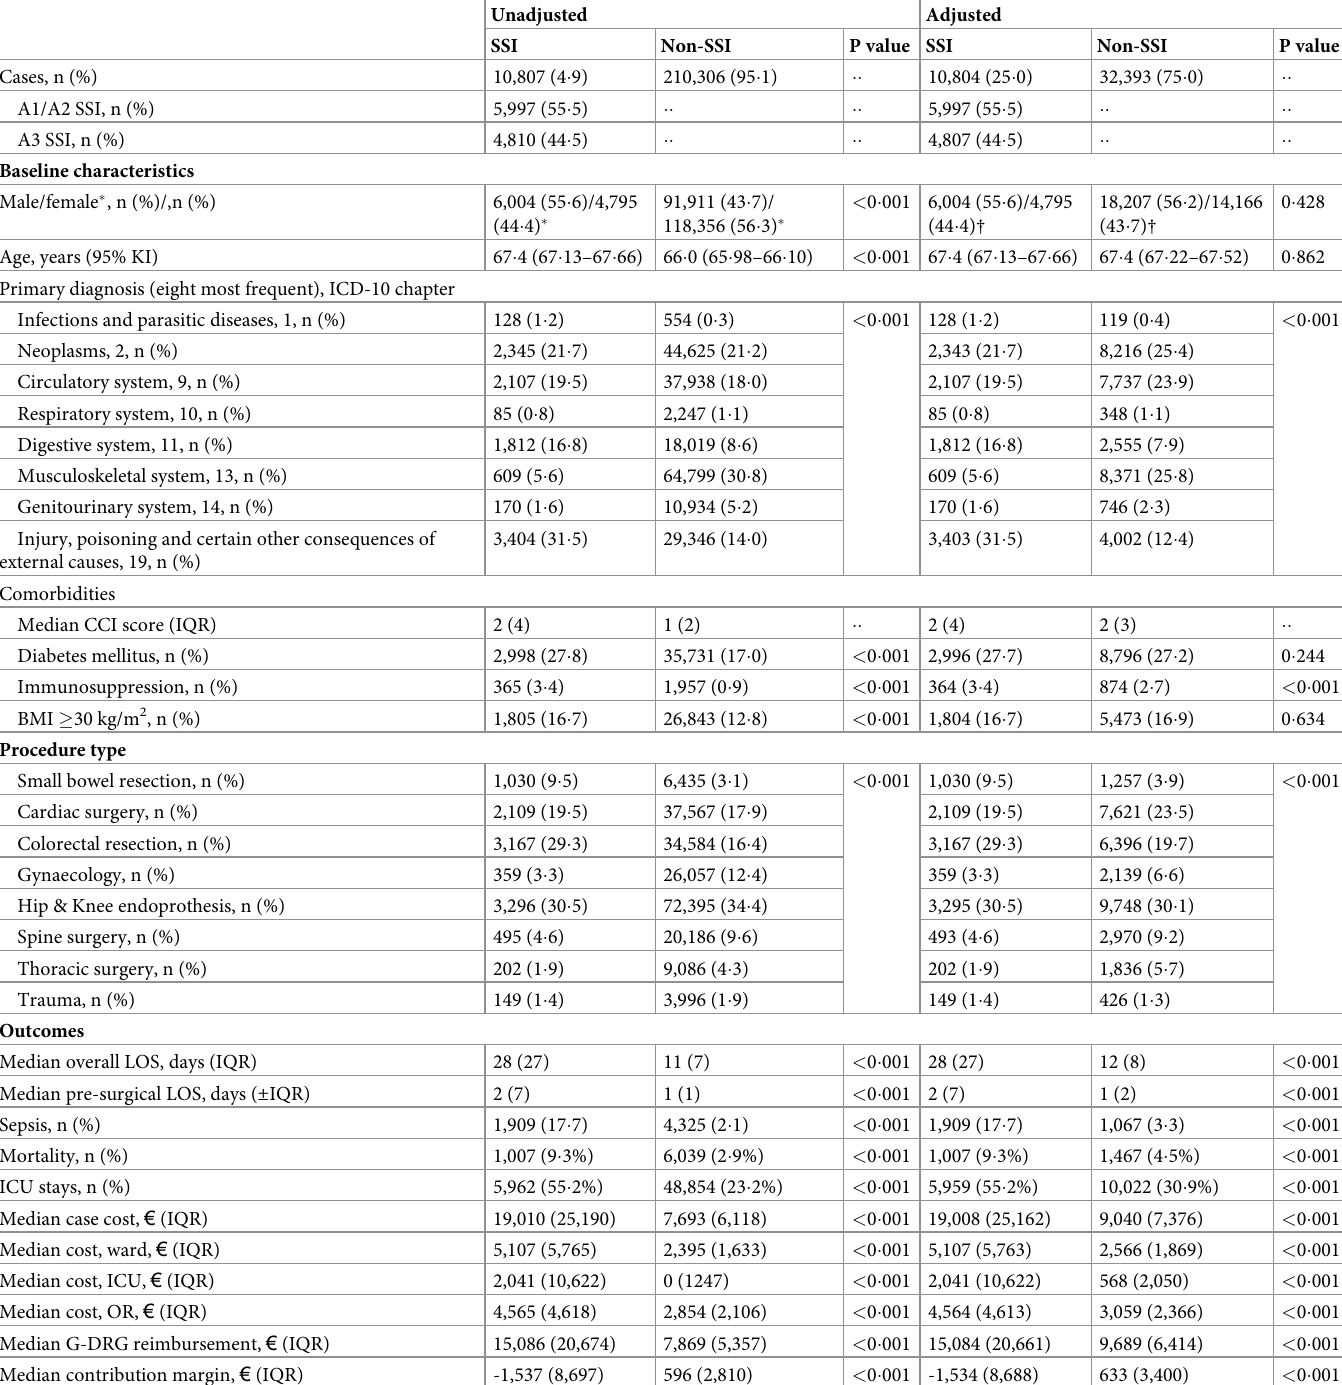
Table 3. Comparison of baseline characteristics and outcomes between SSI and non-SSI cohorts,